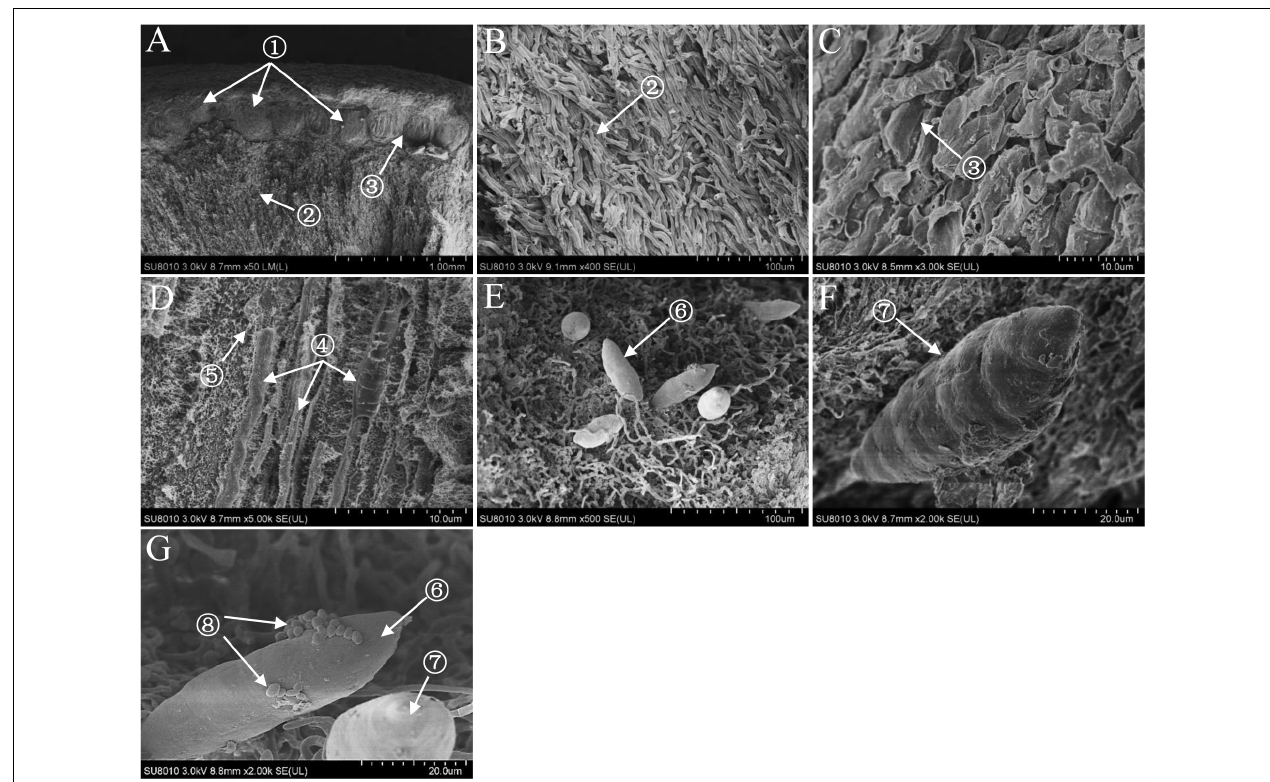
FIGURE 1 | Scanning electron micrographes (A–G) of transverse section of Shiraia stroma. (cid:172) Perithecium; (cid:173) pseudoparenchyma; (cid:174) prosenchyma; (cid:175) ascus; (cid:176) paraphyses; (cid:177) immature ascospore; (cid:178) mature ascospore; (cid:179)